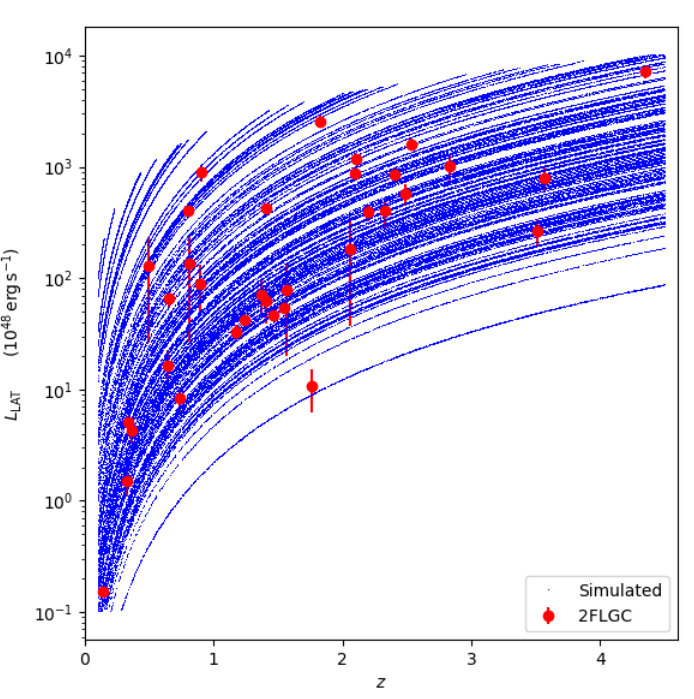
Figure 3. Comparison between the luminosity estimated in the LAT band 0.1GeV (cid:54) E (cid:54) 10GeV for the 2FLGC GRBs with a redshift measurement (large red dots) and the luminosity of the 2FLGC GRBs with 1000 randomly distributed redshifts (small blue